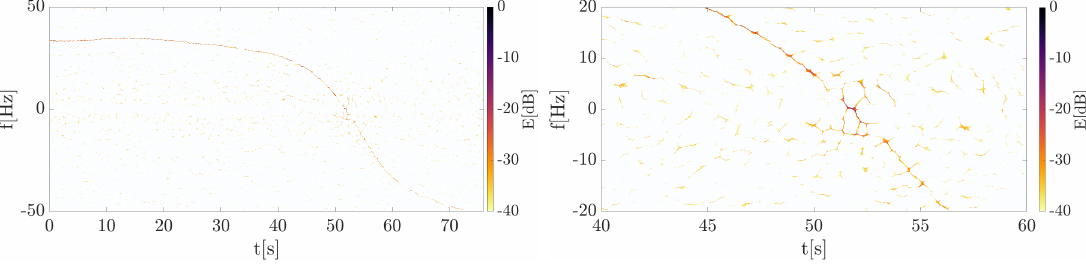
Figure 8. The energy distributions of the measured signal obtained using the concentrated STFT. 178